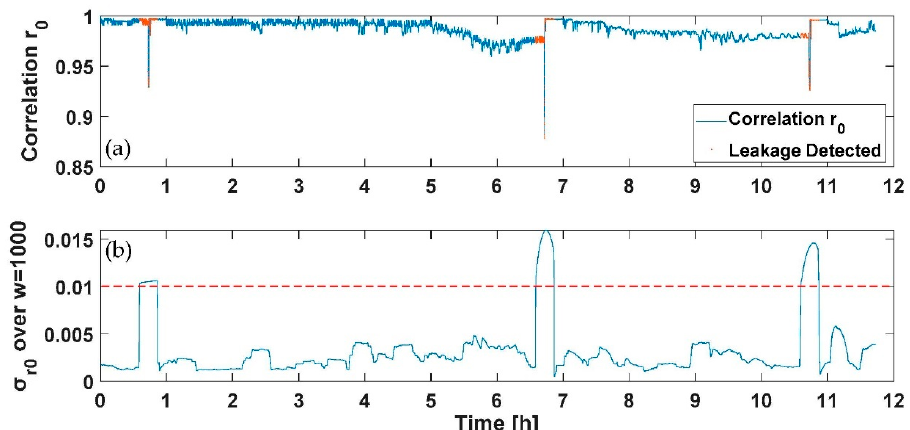
Figure 9. Test on dynamic profile without leakage for the multijet water meter: ( a ) the r 0 correlation and the point detected corresponding to consumption in red, and ( b ) the moving average σ r0 and in red the threshold retrieved from Table 3 to discriminate a flow rate different from zero.